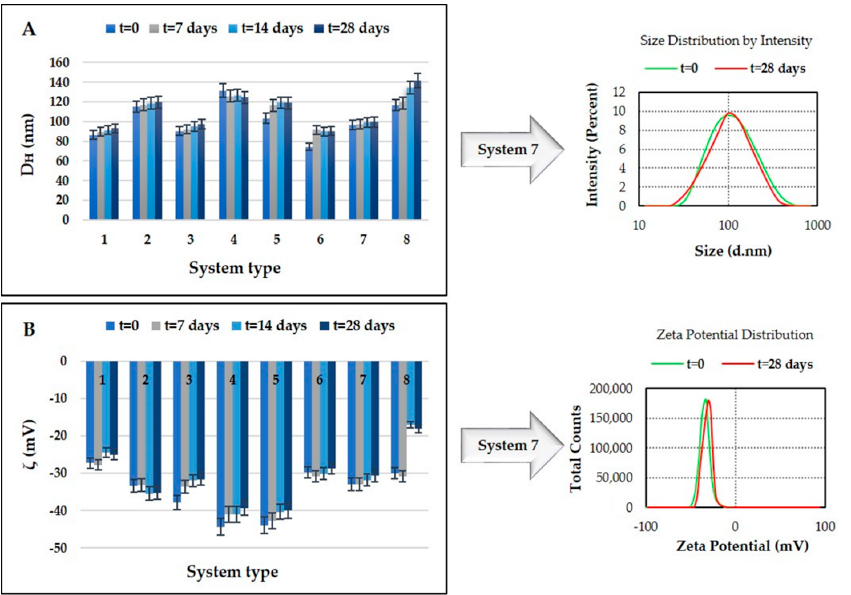
Figure 3. Influence of the storage time on ( A ) mean particle size (D H ) and ( B ) zeta potential ( ζ ) for all the samples after sonication process.